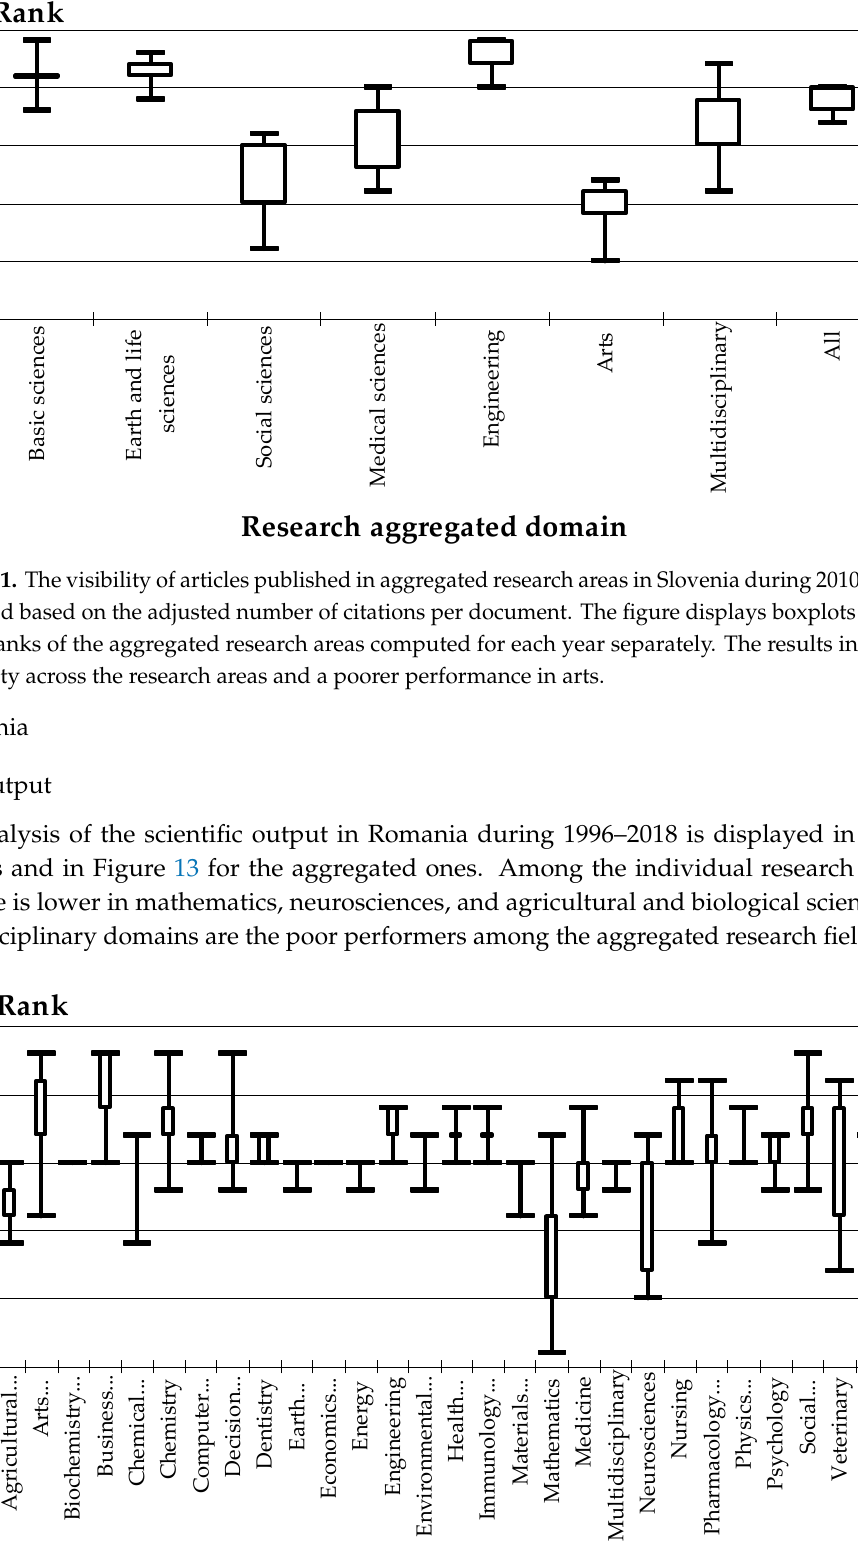
Figure 13. The number of documents published in different aggregated research areas in Romania during 2010–2018, measured based on the adjusted number of citations per document. The figure displays boxplots of the ranks of fields computed for each year separately. Results indicate that the ranks cluster in the first third of the ranking. 3.6.3.2. Visibility If Slovenia was a “top player”, Romania appears to be at the lower end of the “top”. The analysis of the individual fields (Figure 14) reveals overall ranks situated between 17 and 22 for all fields, except for chemical engineering (8), mathematics (13) and computer sciences (13). The better performance is explained by the tradition of research: during the communist times, the dictator’s wife